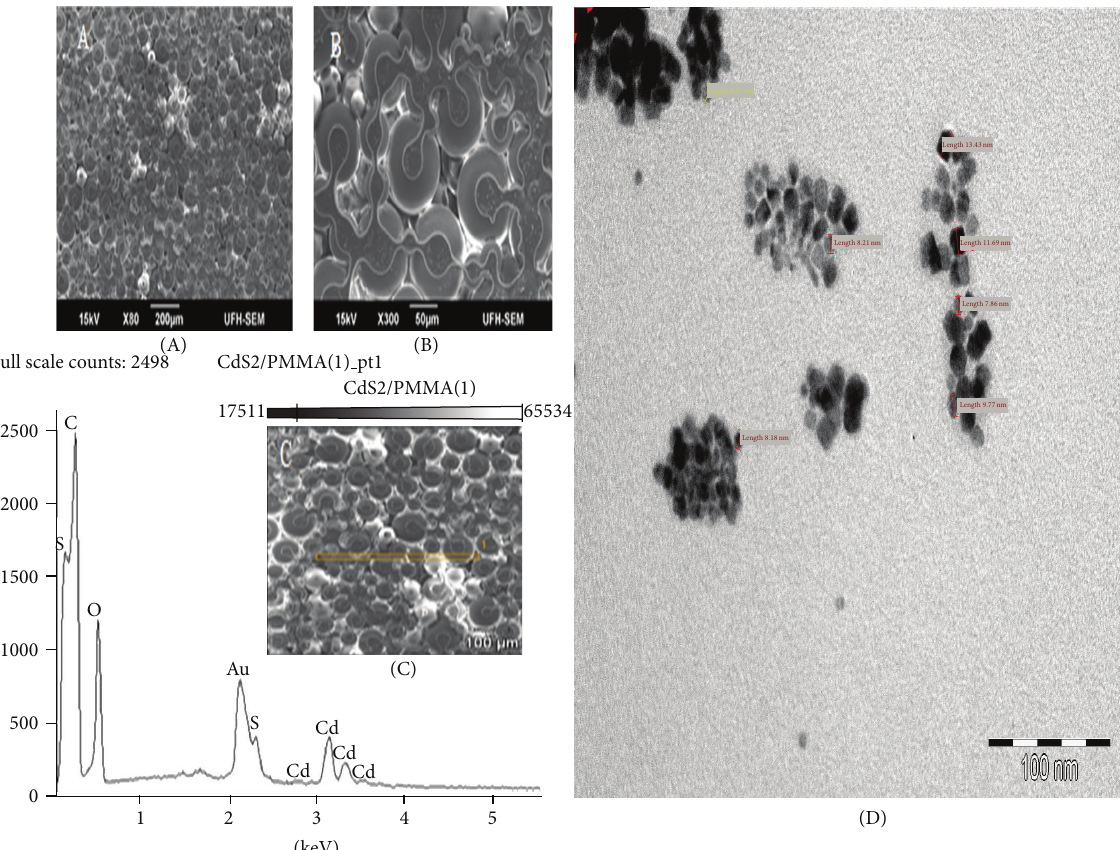
Figure 5: (A) and (B) are SEM micrograph of CdS2/PMMA nanocomposites at different magnification prepared from 3 wt.% CdS2 nanoparticles dispersed in PMMA matrix. (C) EDX spectrum of the sample; (D) TEM